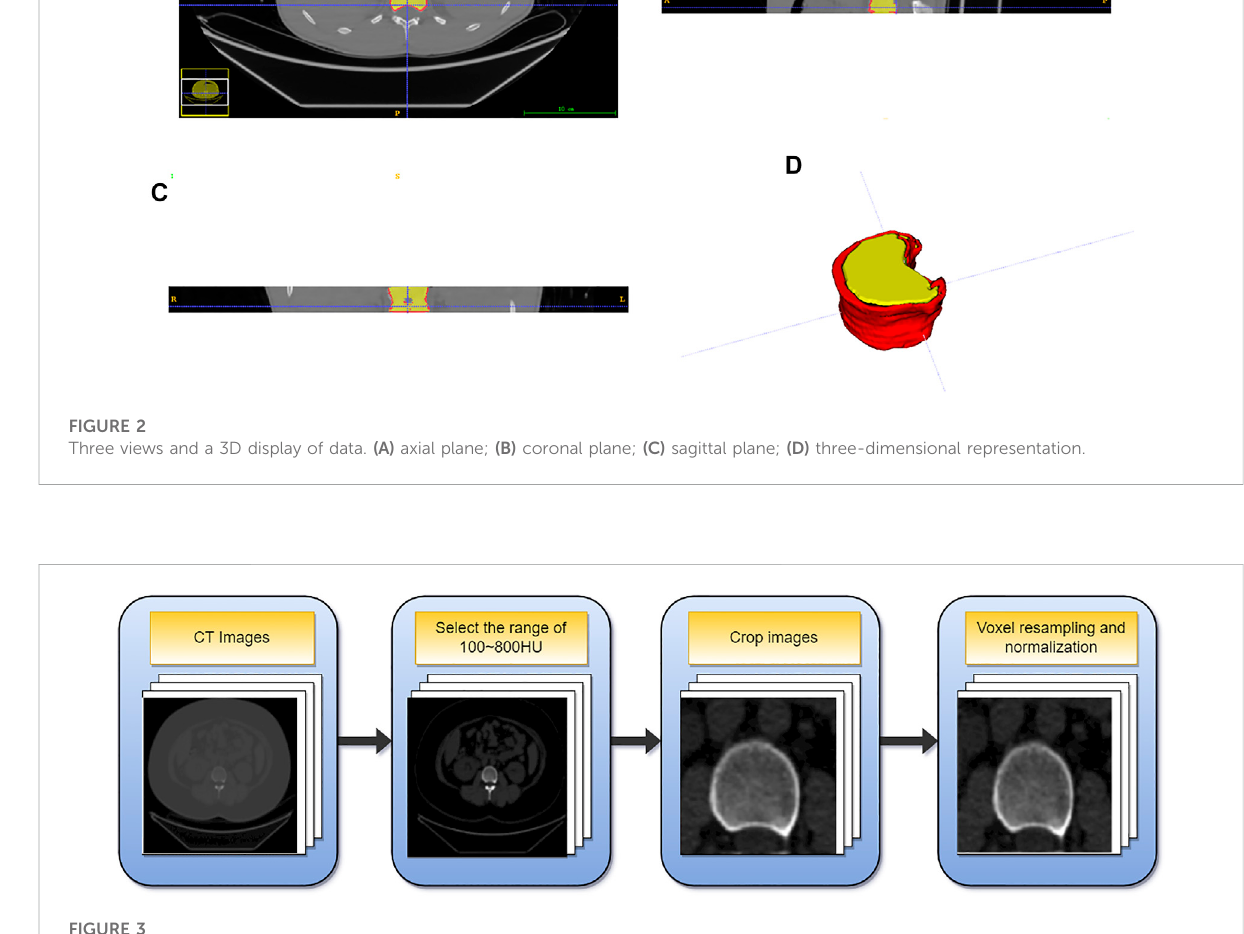
FIGURE 3 The fl owchart of data